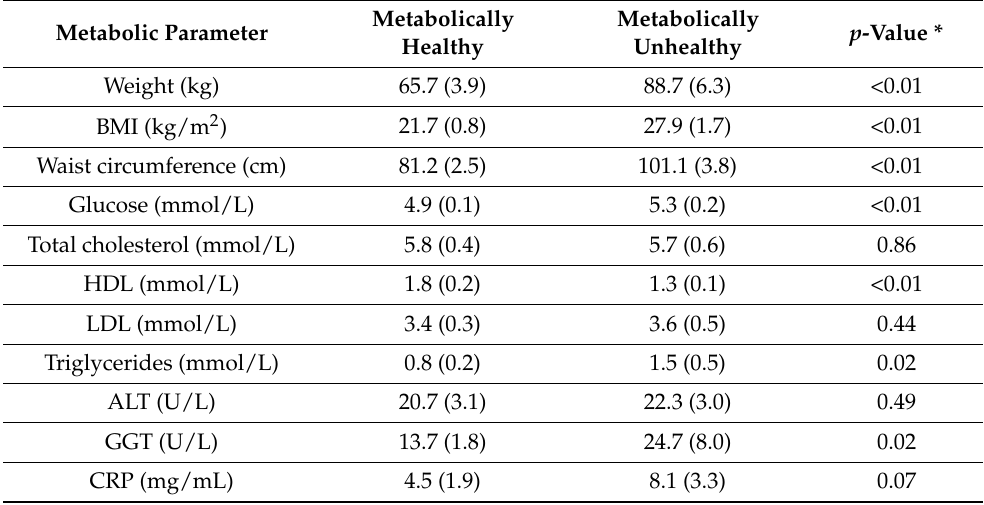
Table 1. Metabolic characteristics of metabolically healthy ( n = 14) and metabolically unhealthy ( n = 14) subjects at baseline.